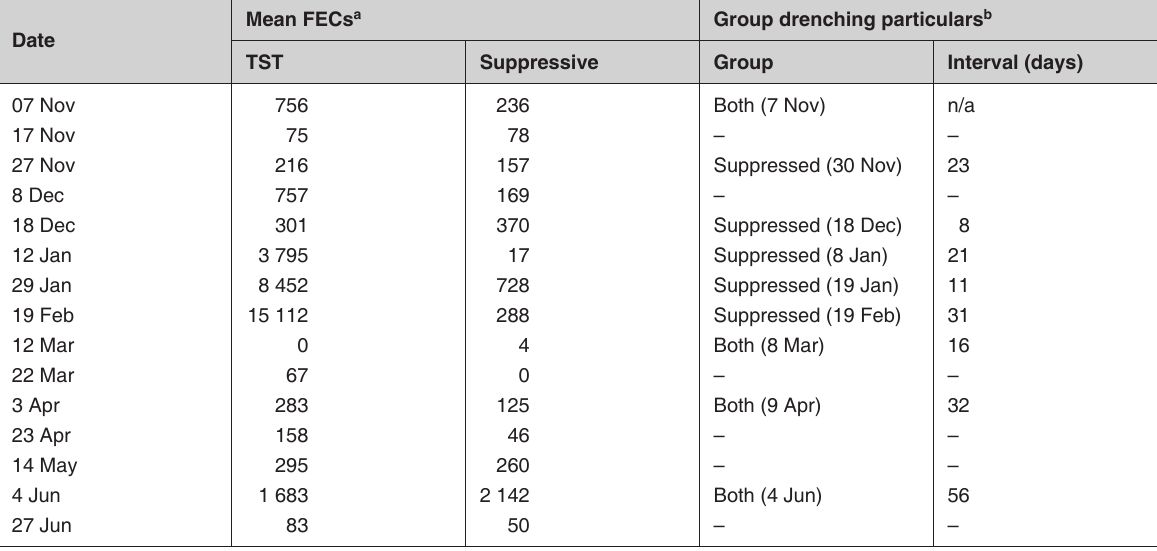
TABLE 2 Experiment 1 (Farm 1, wethers in replacement ram flock): Mean FECs per group of sheep, plus dates on which all groups were drenched